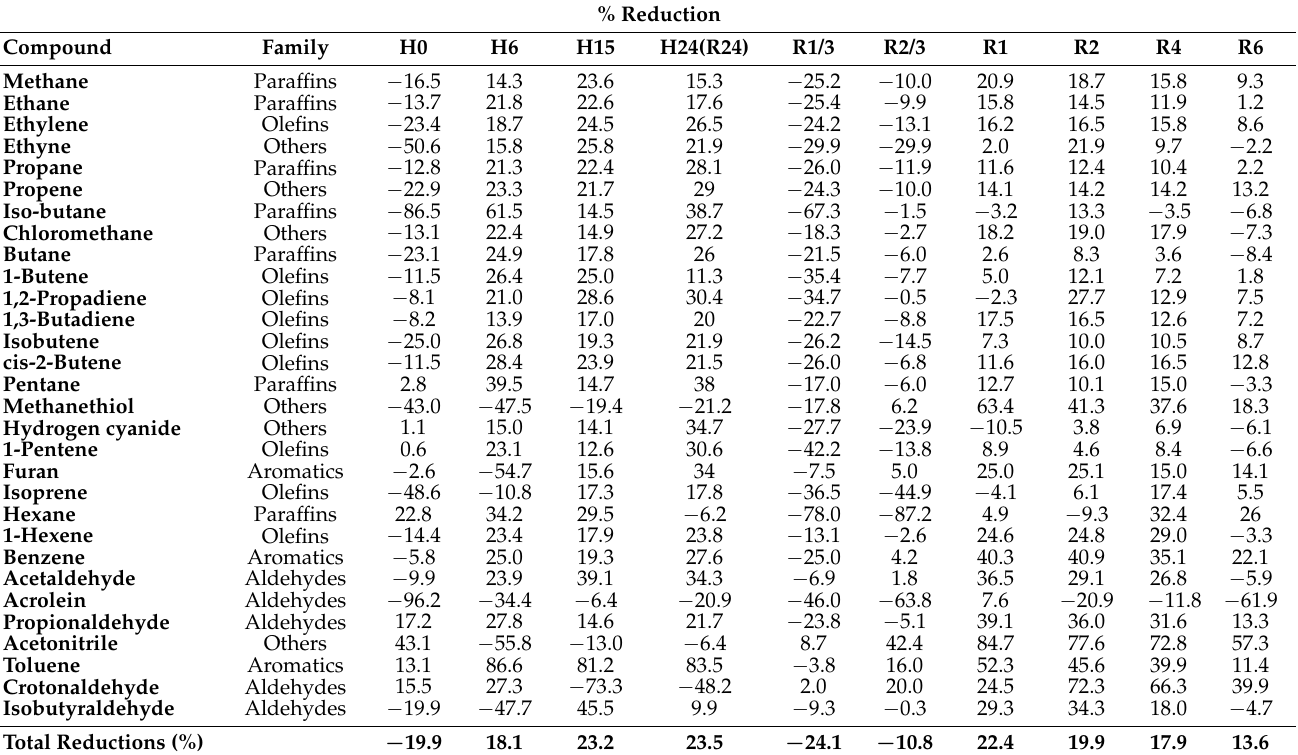
Table 3. Yield reductions obtained in the gas fraction for the different catalysts